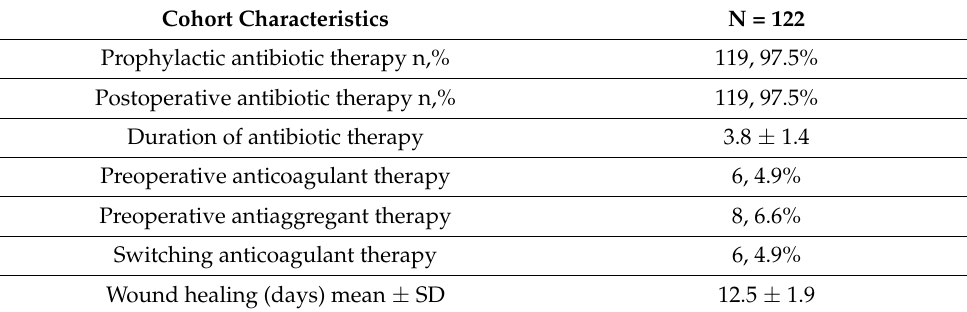
Table 1. Cont. Cohort Characteristics N = 122 Prophylactic antibiotic therapy